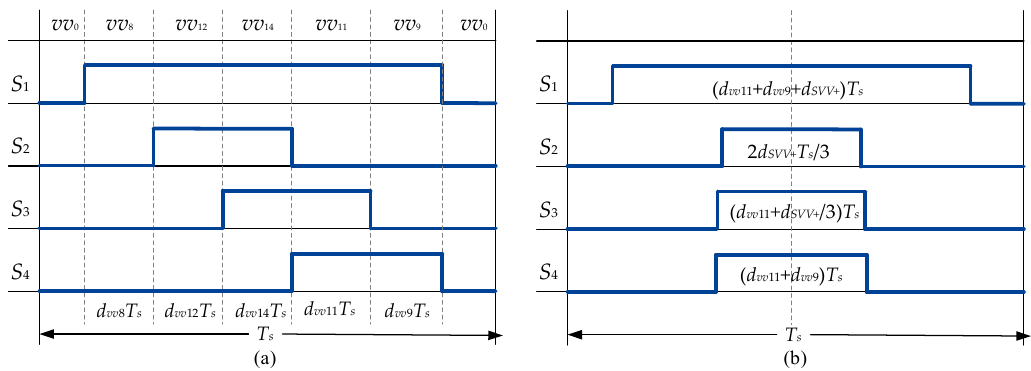
Figure 11. Switching pulses generation: ( a ) original switching pulses; ( b ) rearranged switching pulses.